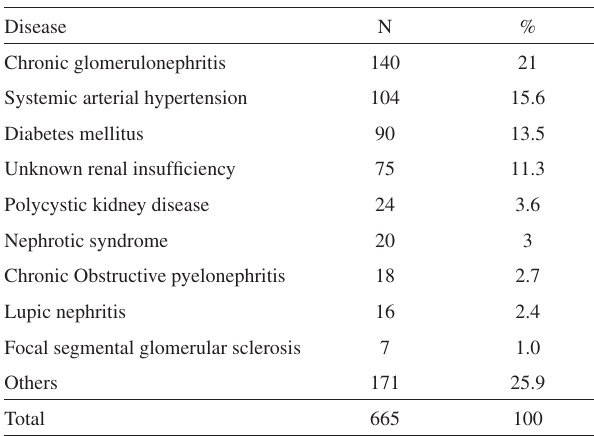
Table 5 - Indications for adult kidney transplantation Disease